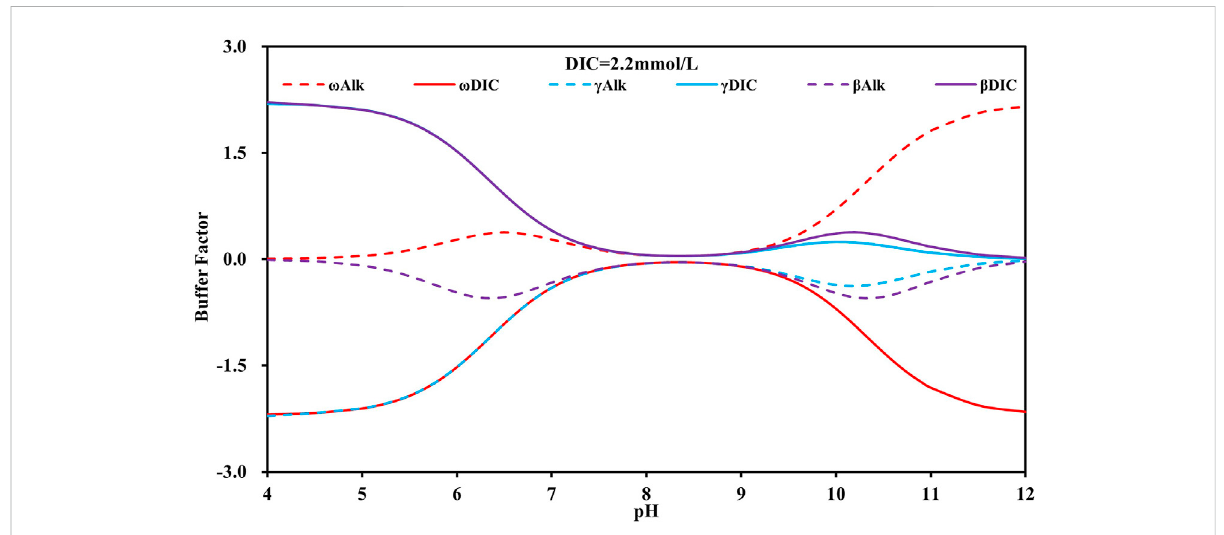
FIGURE 4 Characteristics of buffer factors ( β DIC , β Alk , γ DIC , γ Alk , ω DIC , ω Alk ) relative to pH in the surface seawater